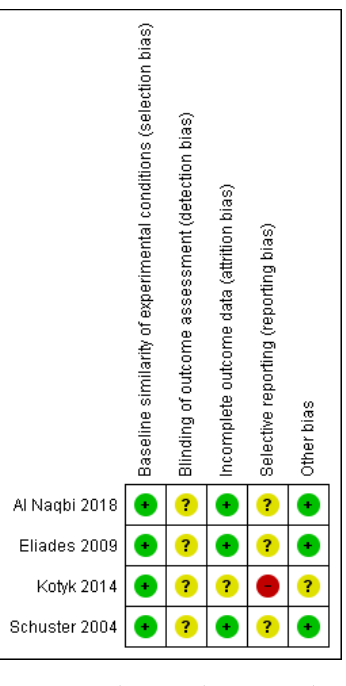
Figure 2. Risk of bias summary: review authors’ judgements about each risk of bias item for each included study. The green plus sign indicates low risk of bias; the yellow question-mark, unclear and the red minus, high. Table 2. Risk of bias of included randomized clinical trial with the RoB 2.0